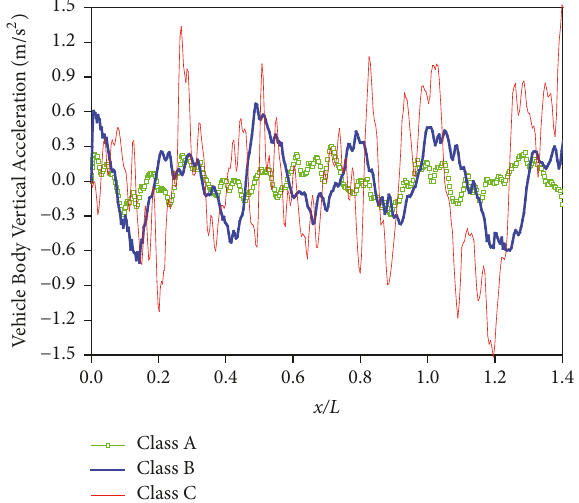
Figure 15: Vertical acceleration of vehicle body with different roughness class.